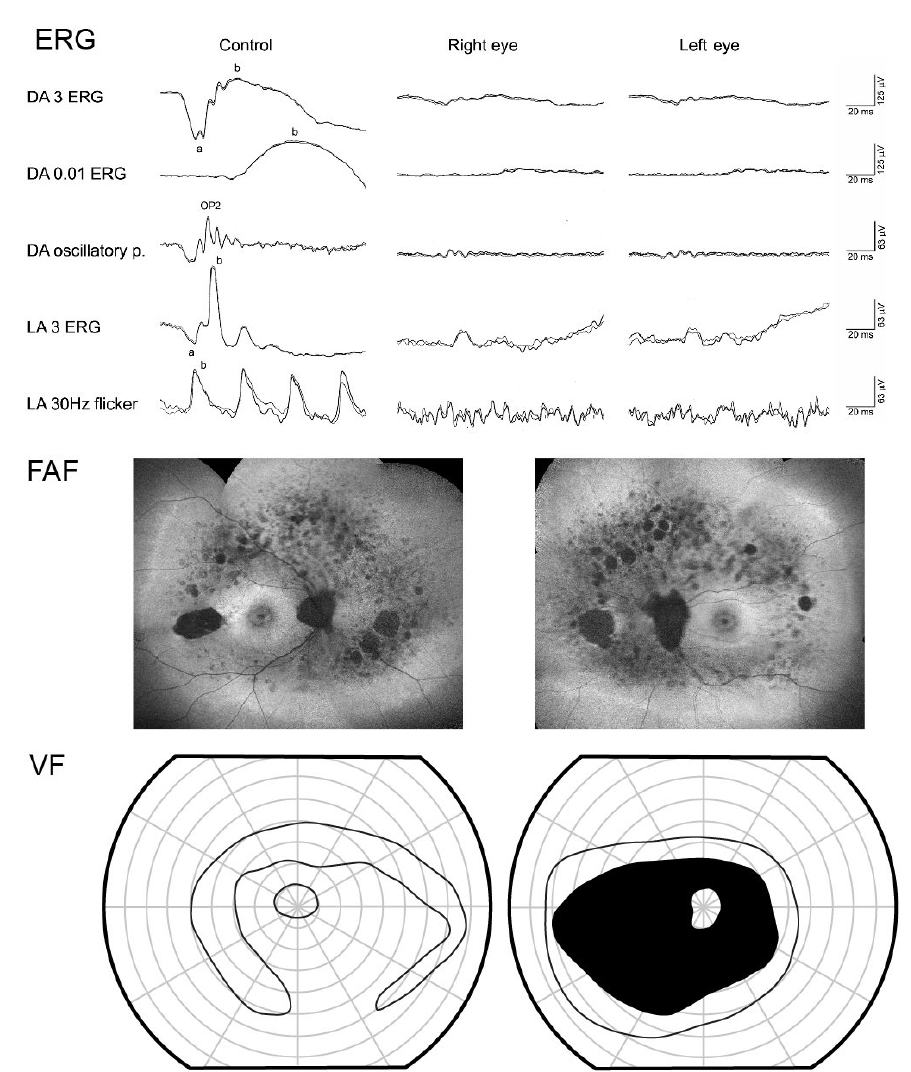
Figure 9. Electrophysiology (ERG), wide - field composite of fundus autofluorescence images (FAF) , and Goldmann visual field (VF) of patient 4, harboring p.(Cys870*) and p.(Arg303His) at the age of 52. ERG showed absent DA 0.01 ERG (rod response) and reduced LA 3 ERG and LA 30 Hz flicker (cone response), typical for rod-cone dystrophy. There was some preservation of the peripheral retina noted on FAF and VF.